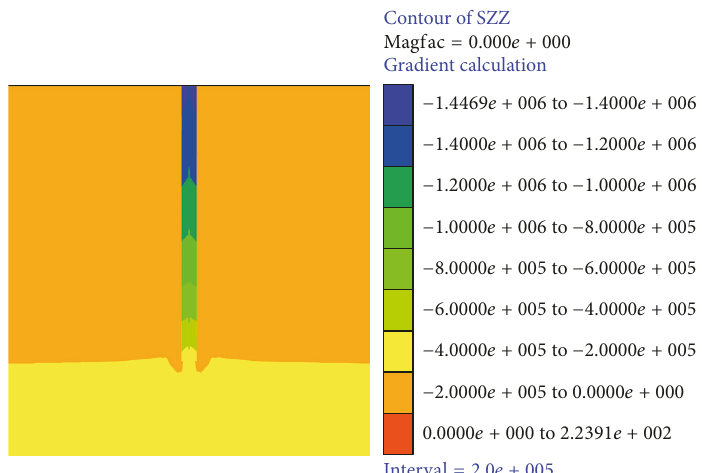
Figure 4: Typical contour of axial stress under a load of 385 kN.